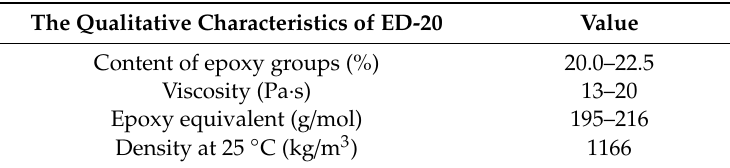
Table 1. Properties of epoxy resin ED-20.